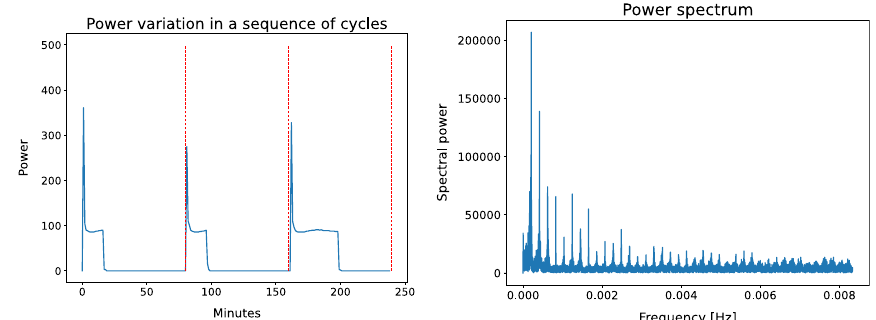
Fig. 2 The power spectrum computed by the periodicity pre-processor (right) on the fridge energy consumption time series (left). The period detected for an ON-OFF cycle is about 80 minutes for the analyzed data set